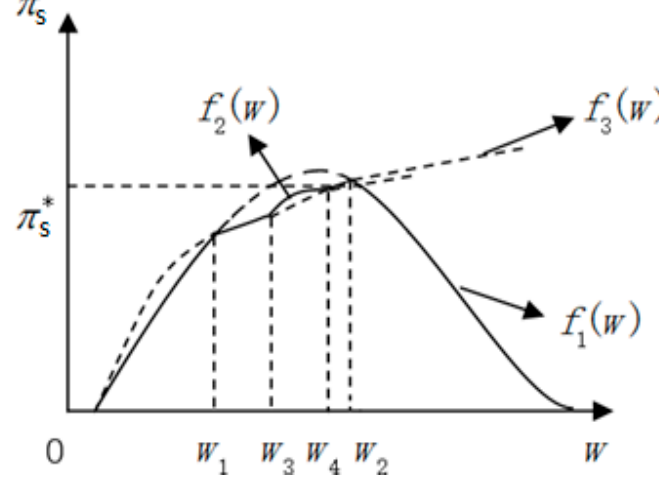
Figure A2. The schematic profit function of the supplier for Case A6.